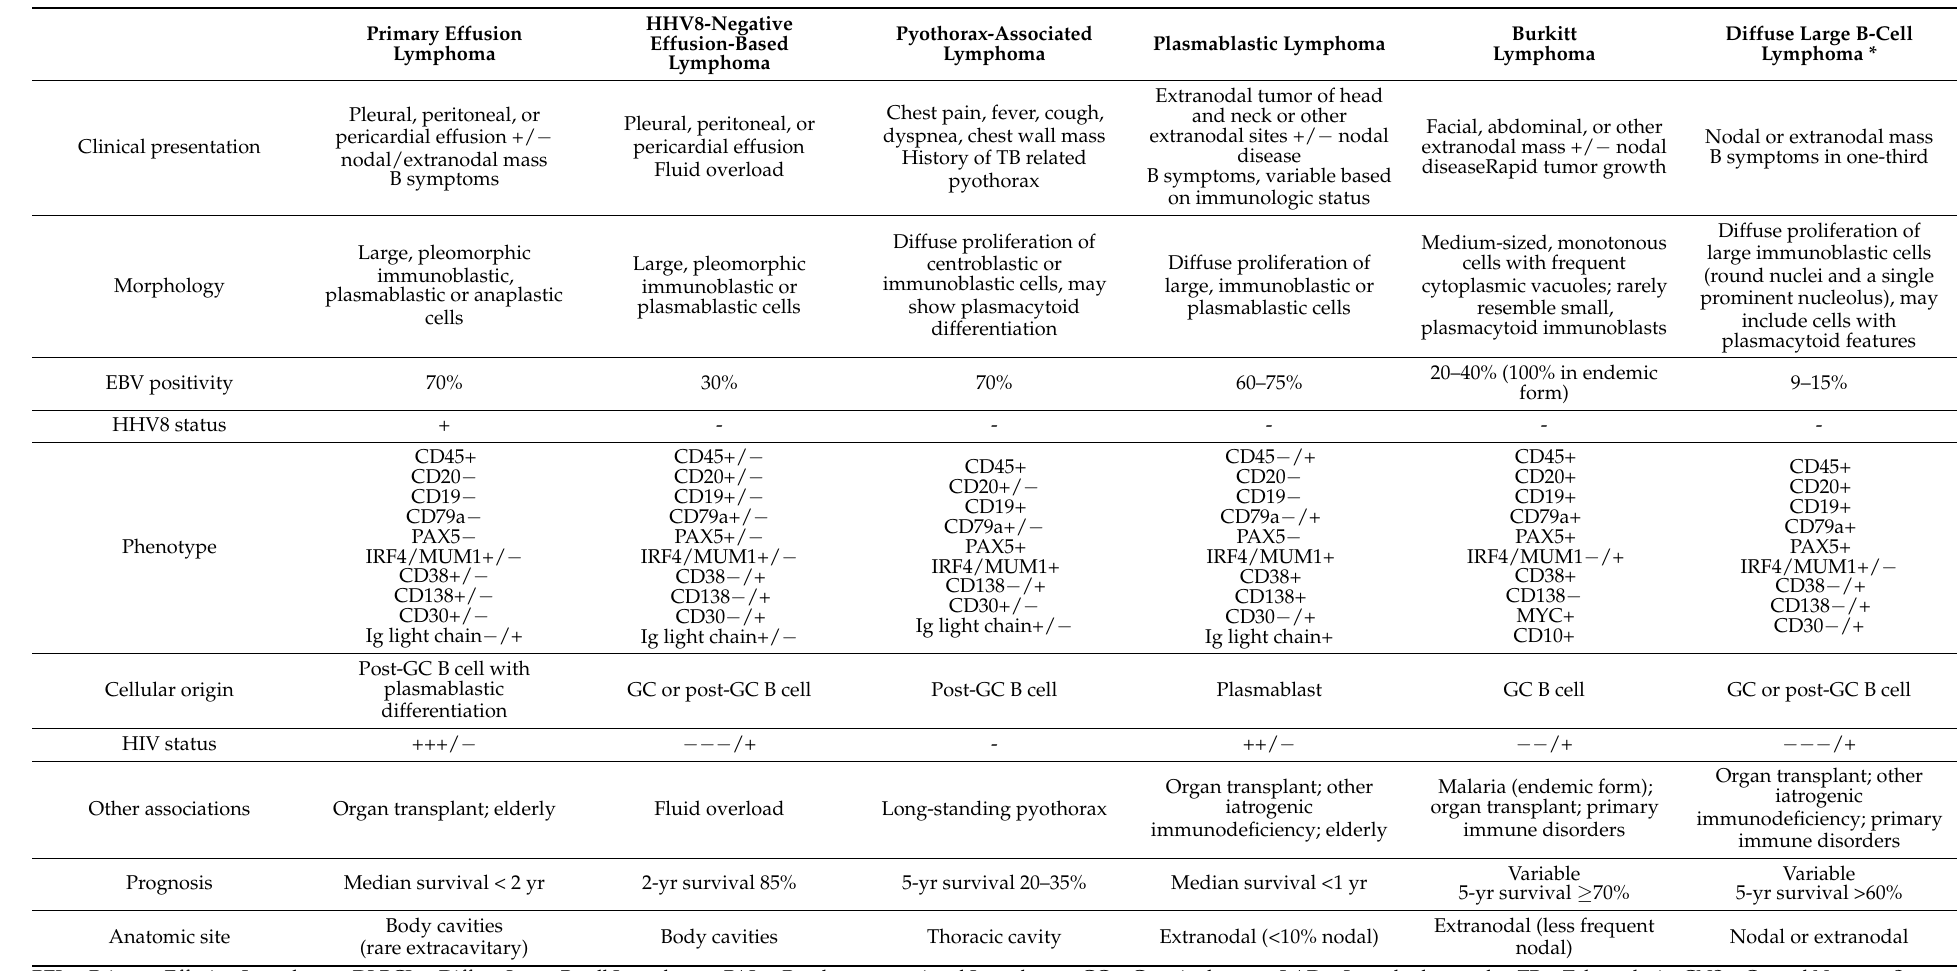
Table 1. Differential Diagnosis of Primary Effusion